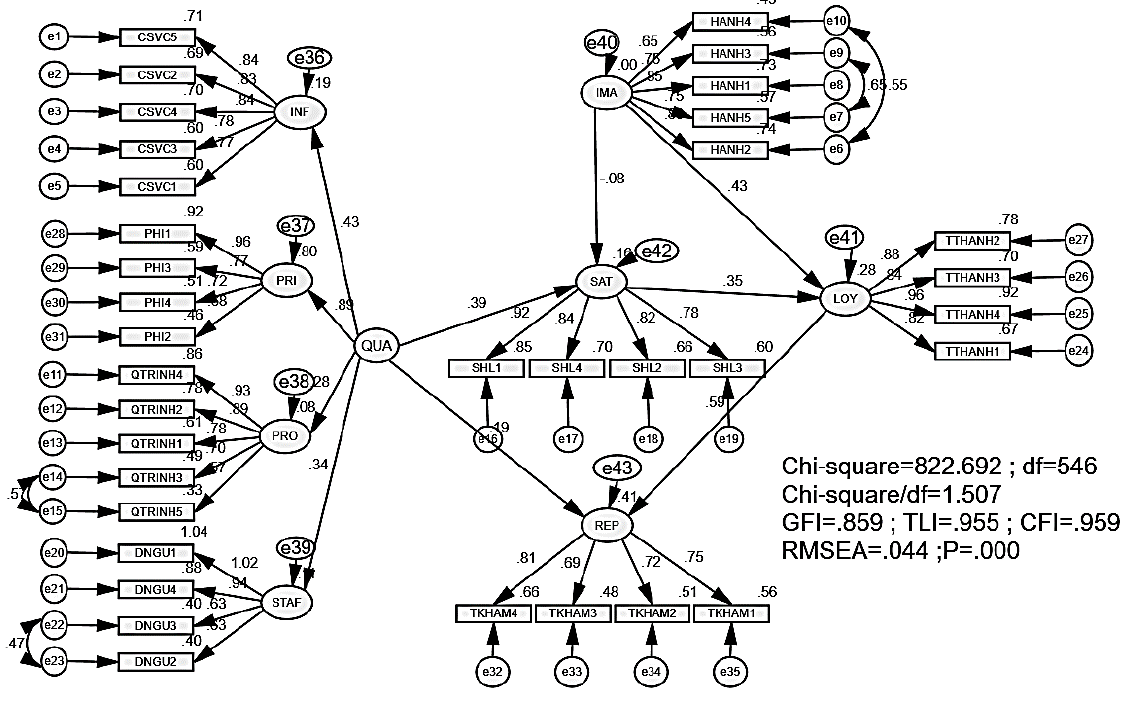
Figure 3. Standardized SEM model outcomes